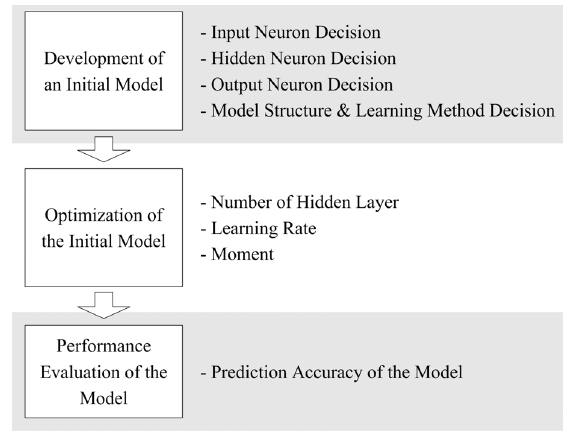
Figure 1. Development process of the prediction model.